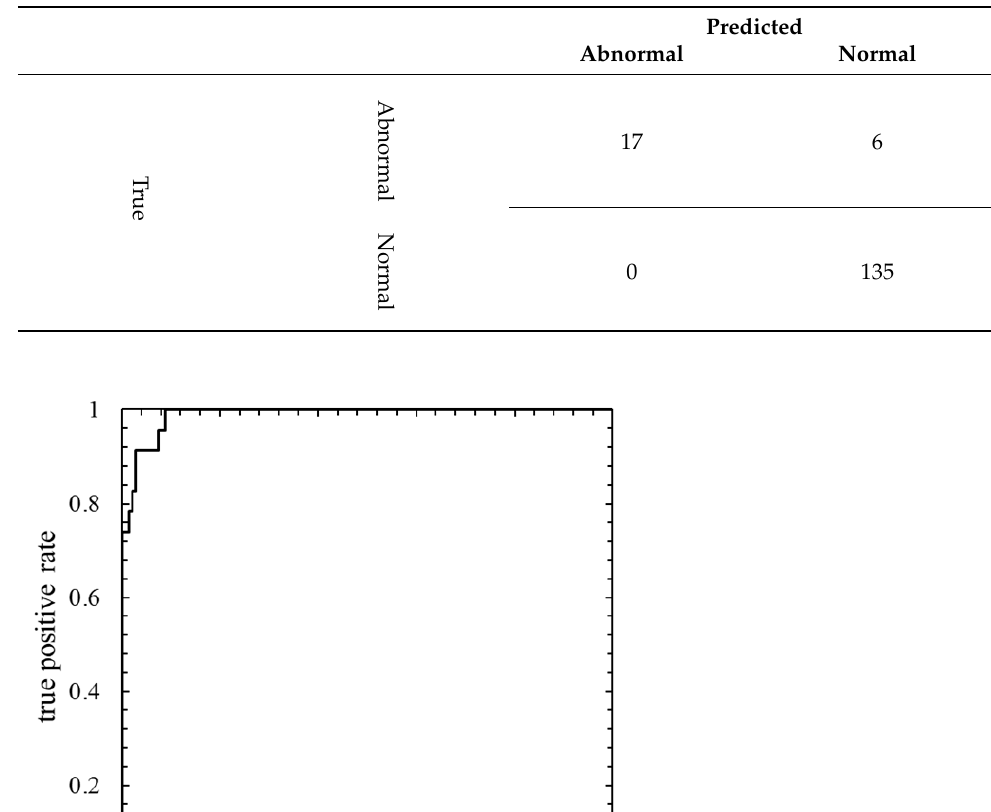
Table 4. Confusion matrix of the model in which the number of mixture components K was deter- mined based on BIC ( K = 29, the threshold is the 99th percentile’s value).